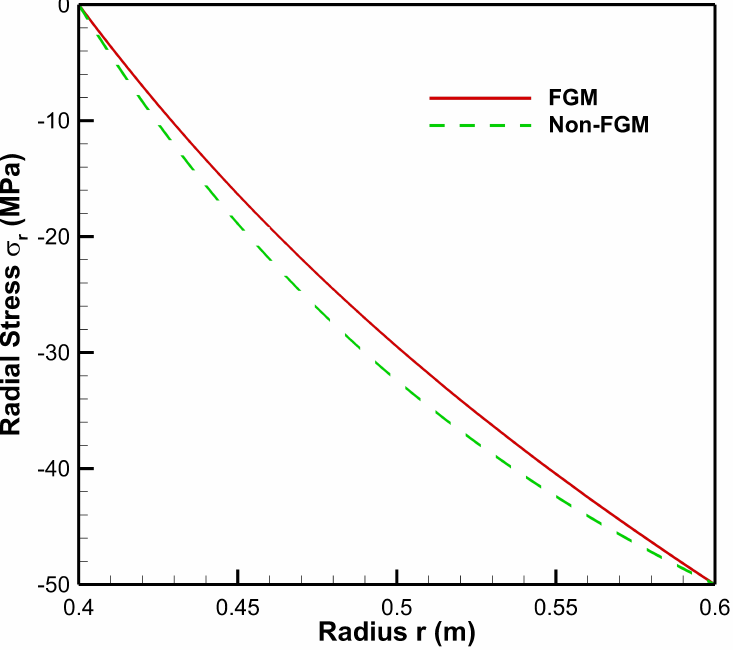
Figure 5. Radial Stress along the radius of the cylinder under external pressure, P b = 50